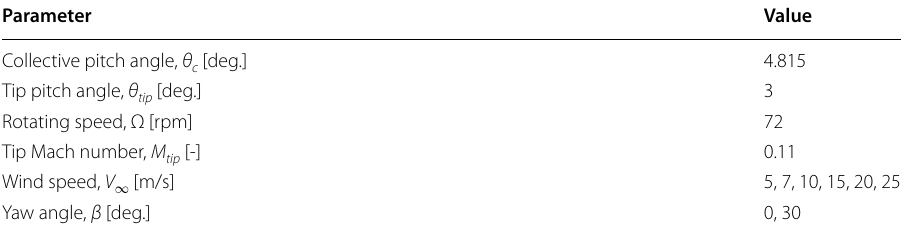
Table 5 Model description of NREL Phase VI rotor [152] Parameter Value Number of blades, N B [-] 2 Chord length, c r 0.75 R [m] =